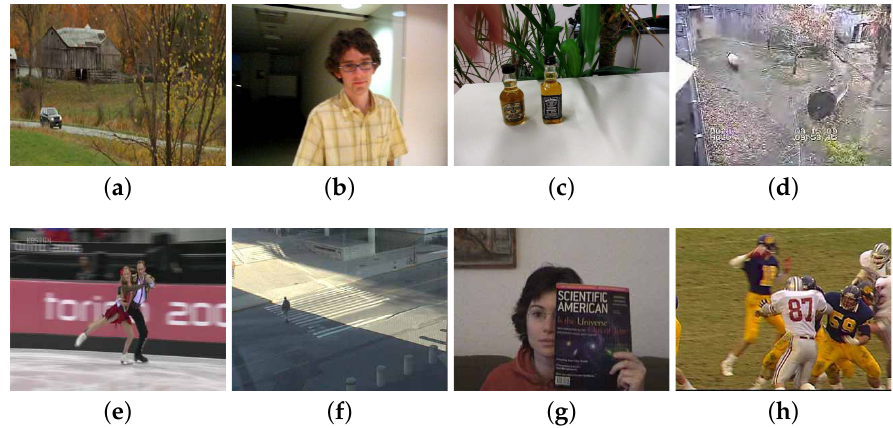
Figure 3. Eight test sequences used in experiment. ( a ) CarScale; ( b ) David; ( c ) Liquor; ( d ) Panda; ( e ) Skating2; ( f ) Crossing; ( g ) FaceOcc1; ( h ) Football1. These eight sequences possess the nine attributes described in the VTB dataset (SV, OCC, FM, etc.). For visual effects, some sequences have been stretched to achieve the same